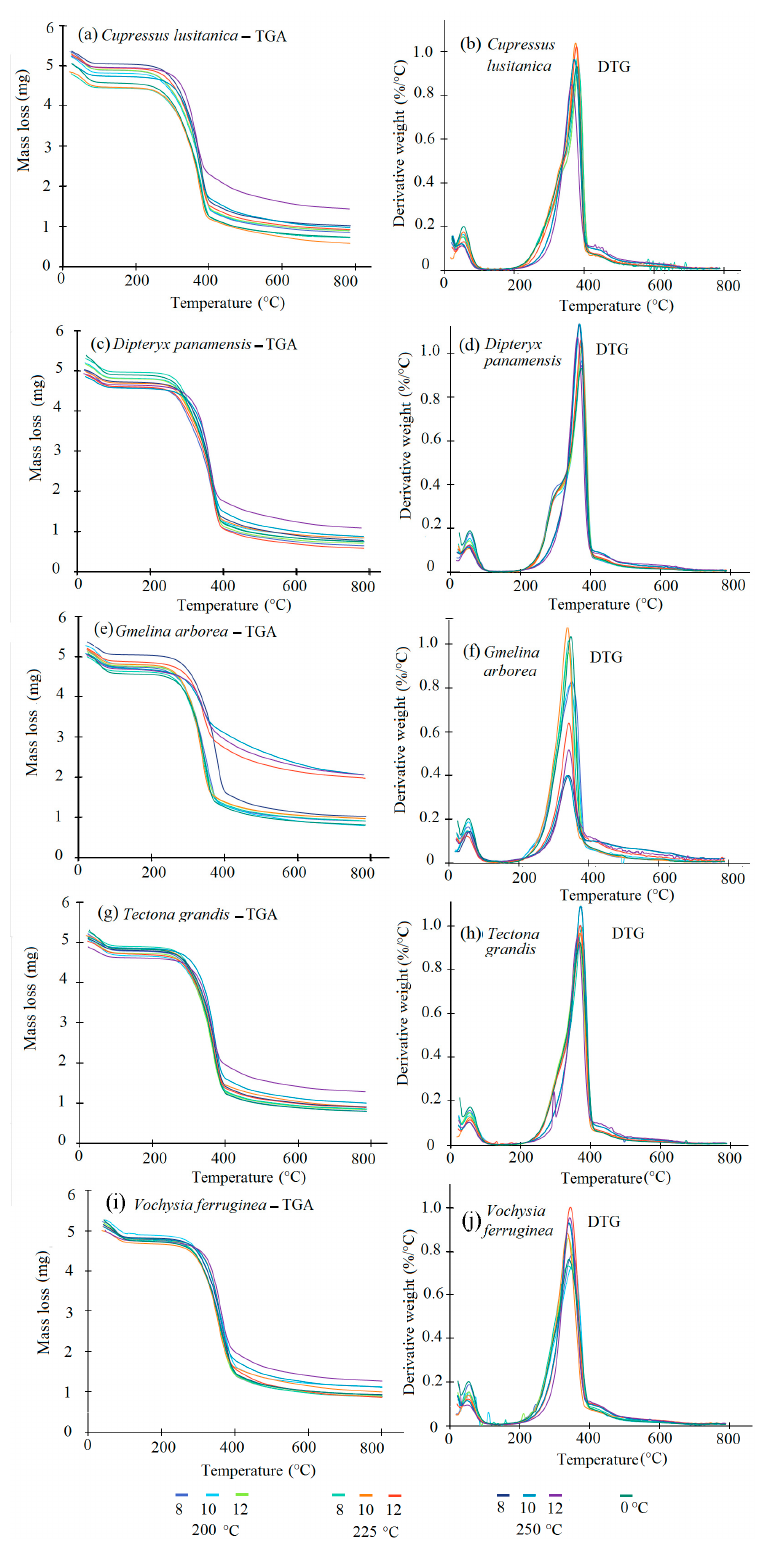
Figure 3. Thermogravimetric analysis (TGA) and DTG of biomasses for Cupressus lusitanica ( a – b ), Dipteryx panamensis ( c – d ), Gmelina arborea ( e – f ) and Tectona grandis ( g – h ) and Vochysia guatemalensis ( i – j ), torrefied at different times and temperatures.